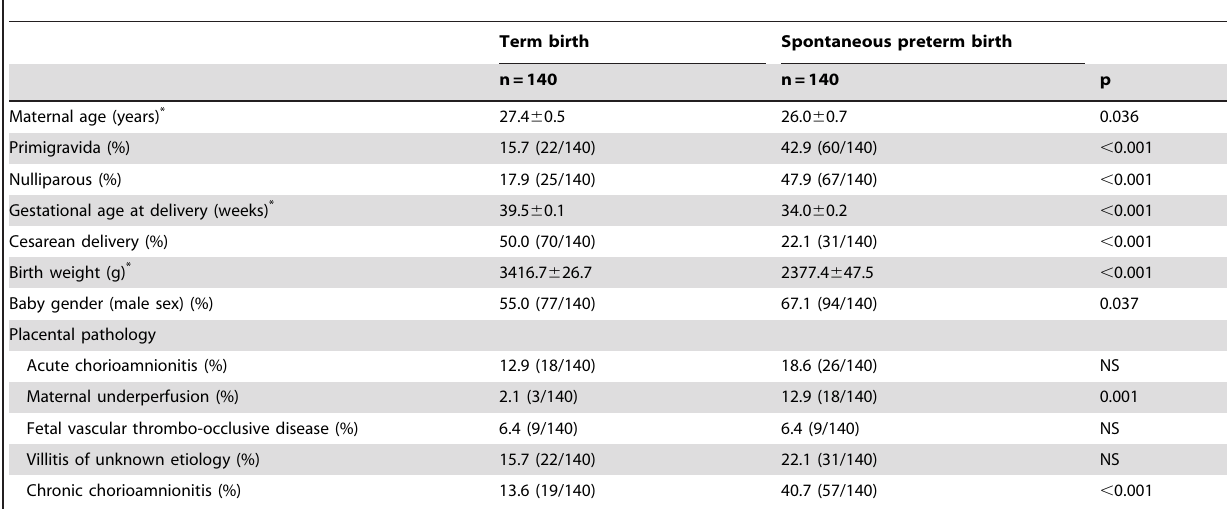
Table 1. Demographics of study